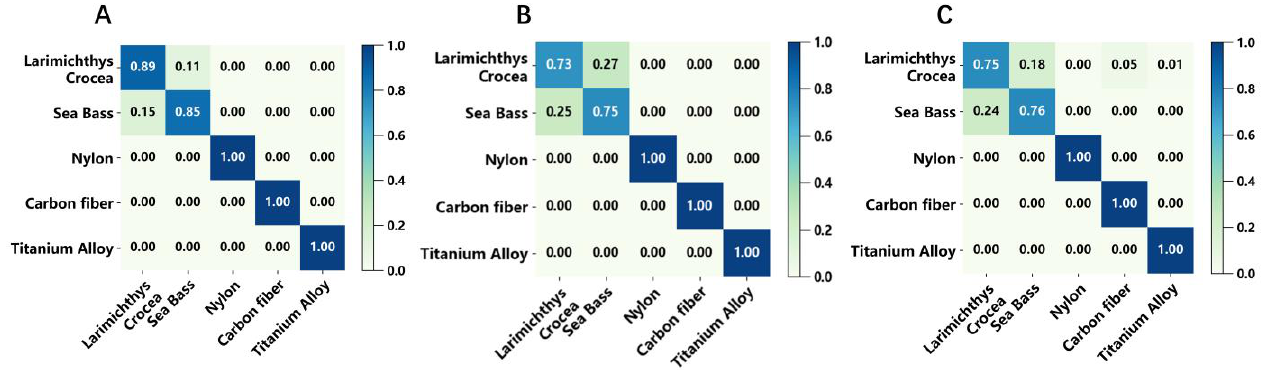
Figure 7. Confusion matrix of various methods. ( A ) SVM; ( B ) LR; ( C ) BP. The longitudinal axis is the real value and the transverse axis is the predicted value. Table 3. Performance of each model in a certain recognition